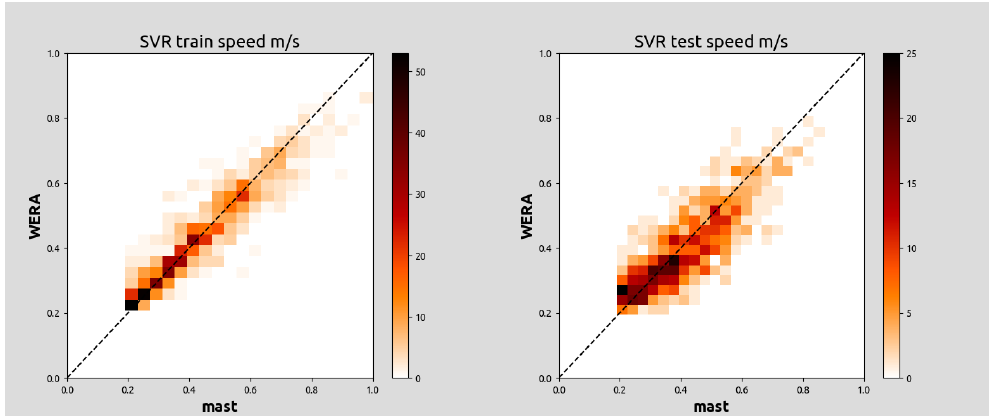
Figure 3. Comparison of Liverpool Bay SVR scaled wind speeds with anemometer. Left : training Right : test. Colour-coding is number of cases in each bin.